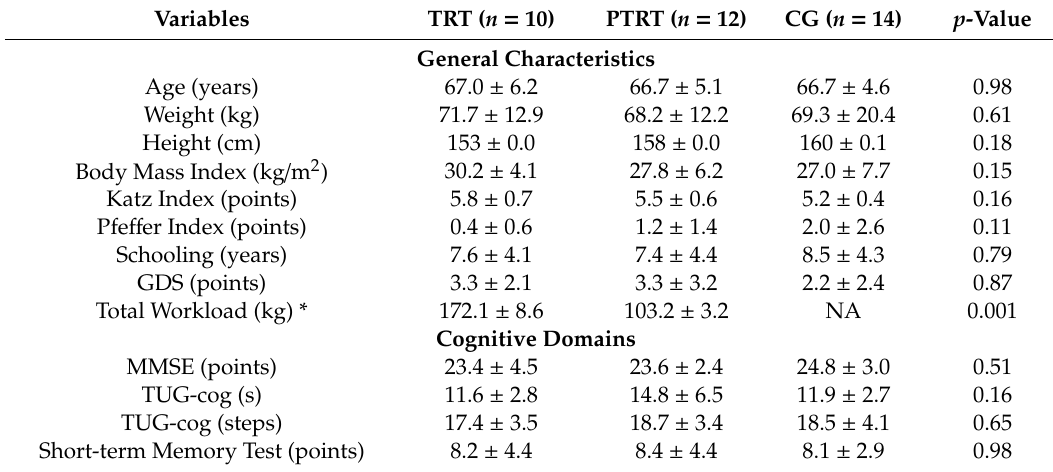
Table 1. Baseline characteristics according to group allocation.